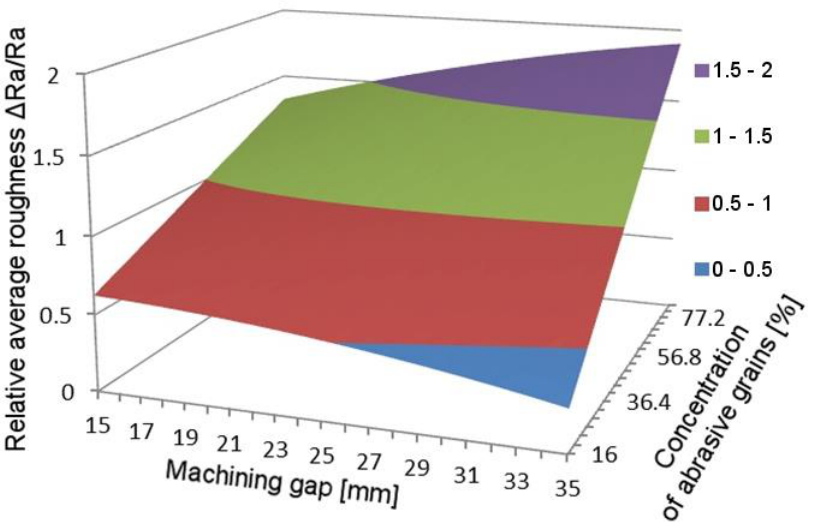
Figure 25. The impact of machining gap width and concentration of abrasive grains, at constant processing time ( T = 15 min), on relative change in roughness Δ Ra / Ra (correlation coefficient R = 0.59).